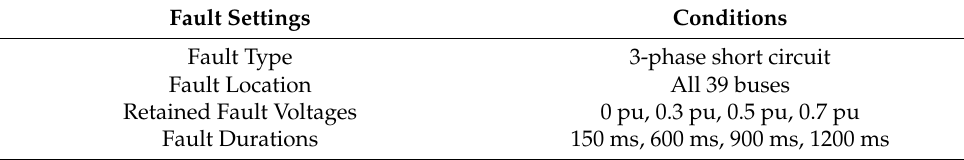
Table 1. Summary of the various fault conditions used for the stability/security